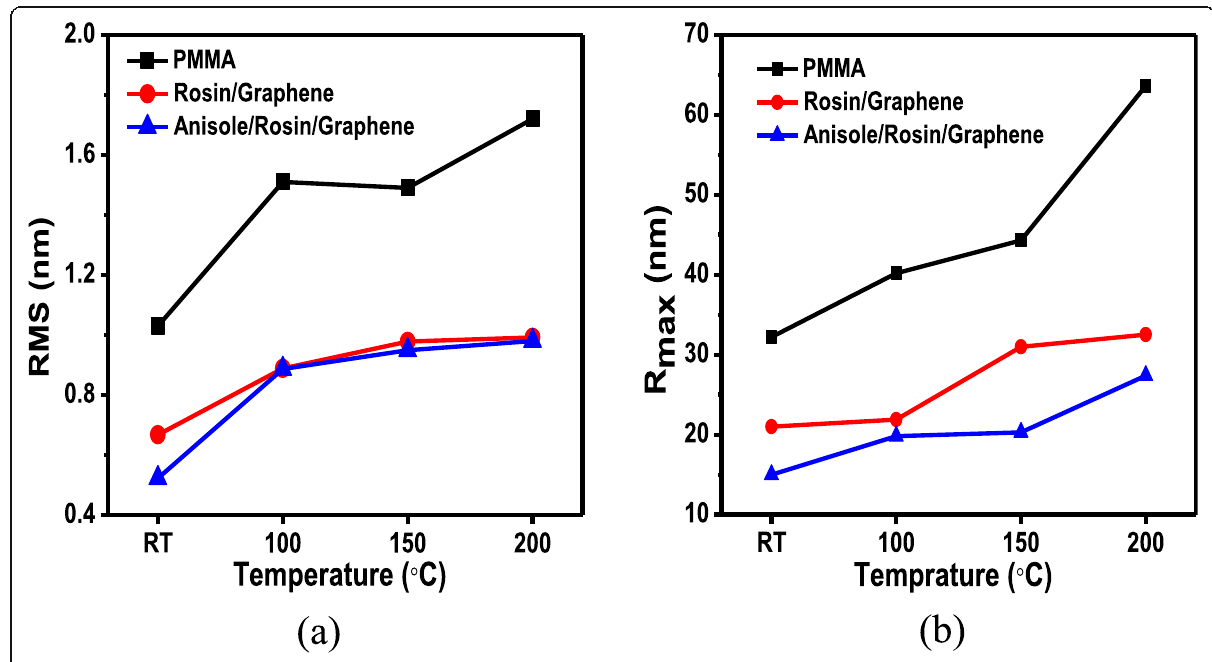
Fig. 6 a Root mean square (RMS) (nm) roughness of PMMA, rosin/graphene, and anisole/rosin/graphene. b Maximum height ( R max ) of PMMA, rosin/graphene, and anisole/rosin/graphene coated